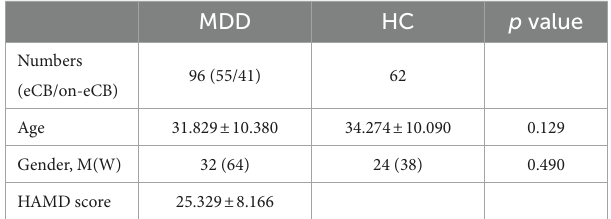
TABLE 1 Demographic and clinical characteristics of patients with MDD and healthy